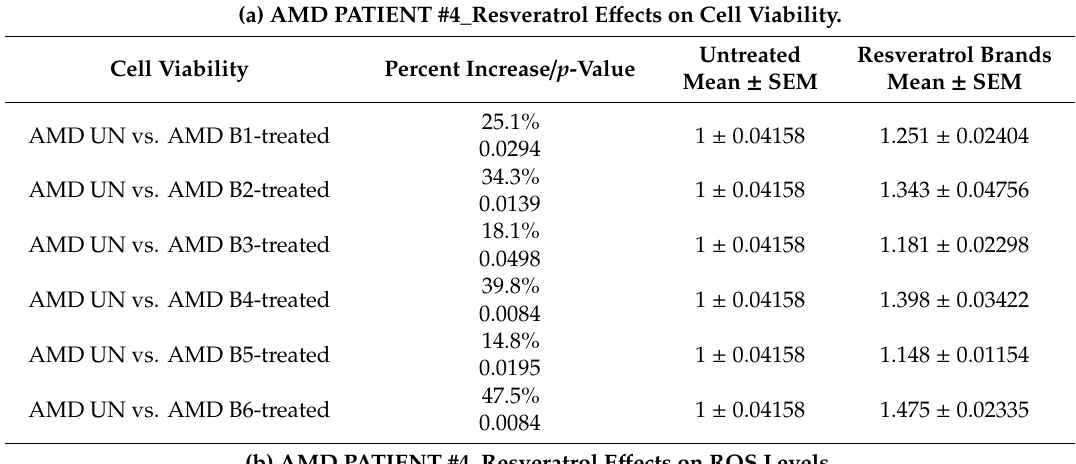
Figure 6. Effects of resveratrol formulations on cell viability ( A ) and ROS levels ( B ) in AMD patient